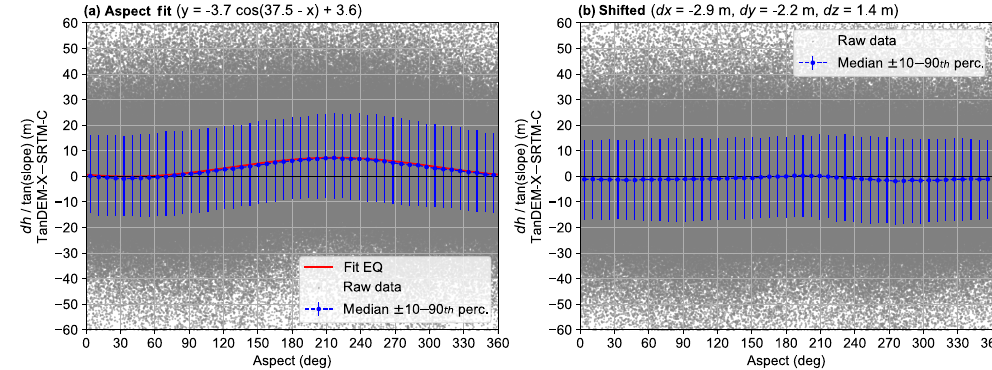
Figure 2. Relationship of dh (normalized by the tangent of the slope) to aspect (a) before and (b) after co-registration and bilinear resampling of SRTM-C. We fit to Eq. (1) on all raw data. Note the close match between equation fit and median values. The cosine relationship in (a) is caused by overestimation of the SRTM-C on NE-facing aspects (peaking at ∼ 60 ◦ ) and underestimation on SW-facing aspects (peaking at ∼ 220 ◦ ). The resulting ( dx , dy ) shift vector is directed SW.